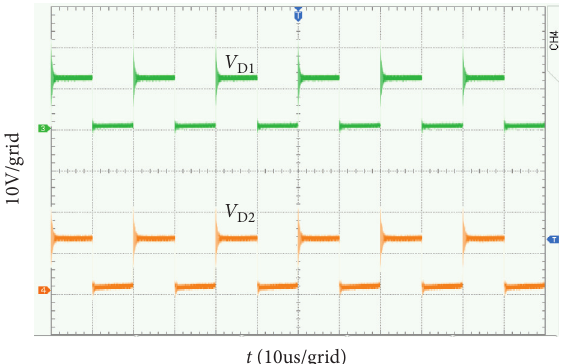
Figure 17: Waveform of V